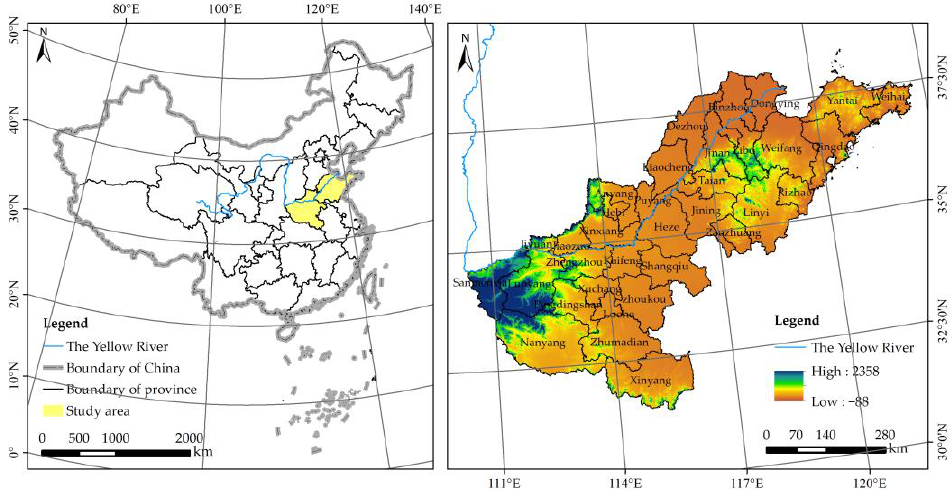
Figure 1. Location of the study area .